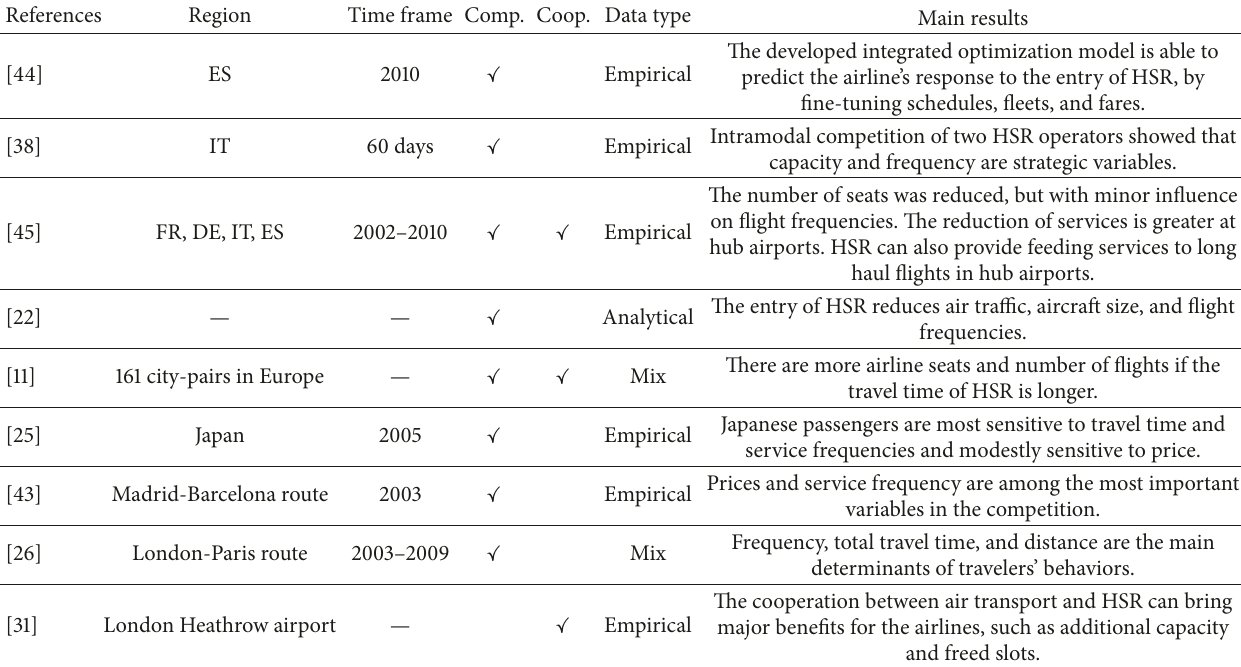
Table 8: The competition and cooperation effects between air transport and HSR on seats and